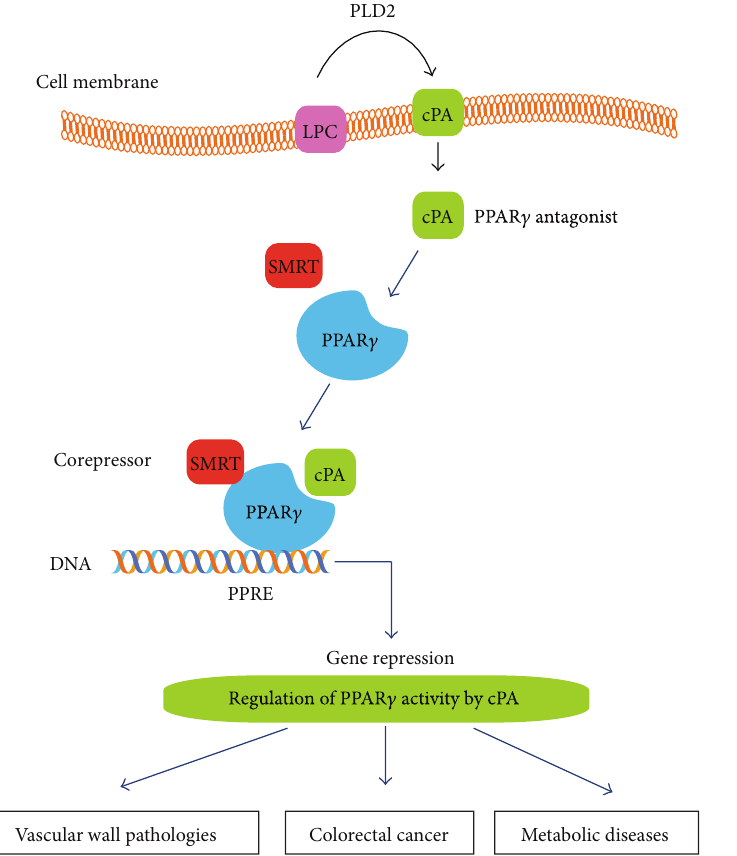
Figure 1: Regulation of PPAR 𝛾 activity by cPA. cPA is generated intracellularly in a stimulus-coupled manner by the PLD2 enzyme. cPA stabilize interactions with corepressor, such as SMRT, that act to repress gene transcription. This endogenous cPA regulates PPAR 𝛾 function required for vascular wall pathologies, colorectal cancer cell growth, and metabolic